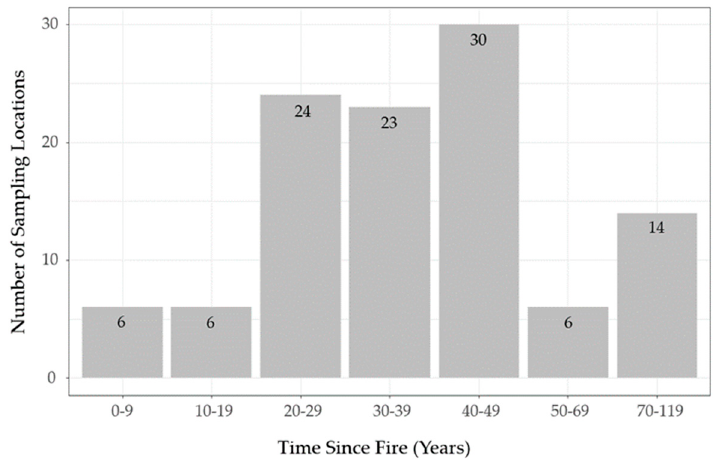
Figure 3. Distribution of sampling locations used to quantify lichen abundance across the local time-since-fire continuum in Woodland Caribou Provincial Park, Ontario, Canada ( n = 109).